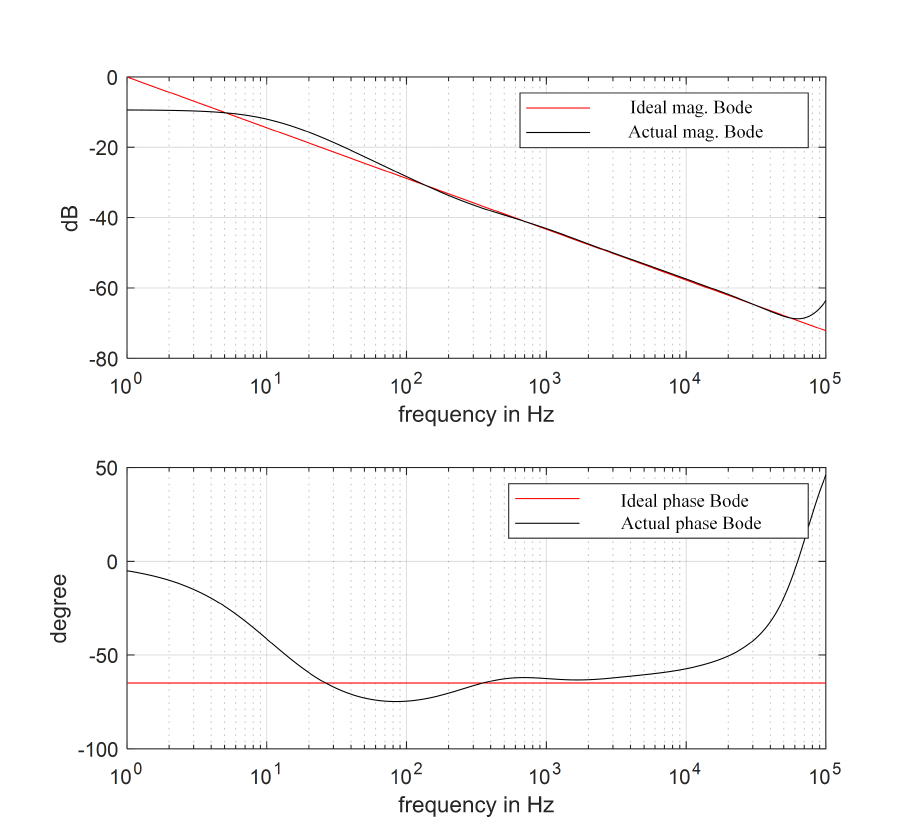
Figure 11. The comparison of discretization approximate bode graph and ideal bode graph of 1/ s α q .